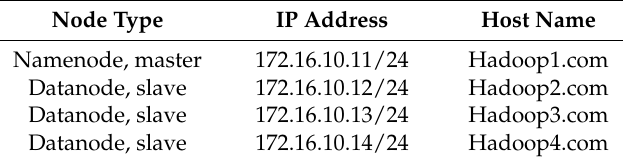
Table 2. Network configurations.